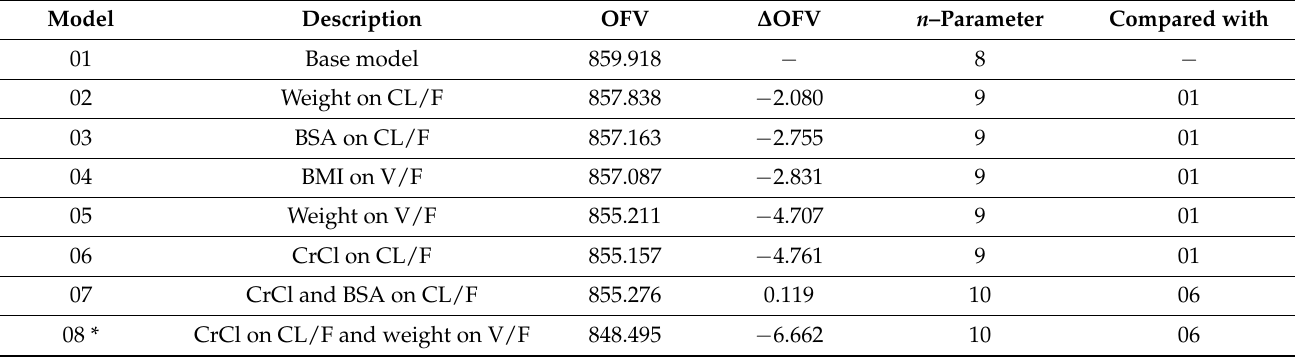
Table 4. Stepwise search for covariates.